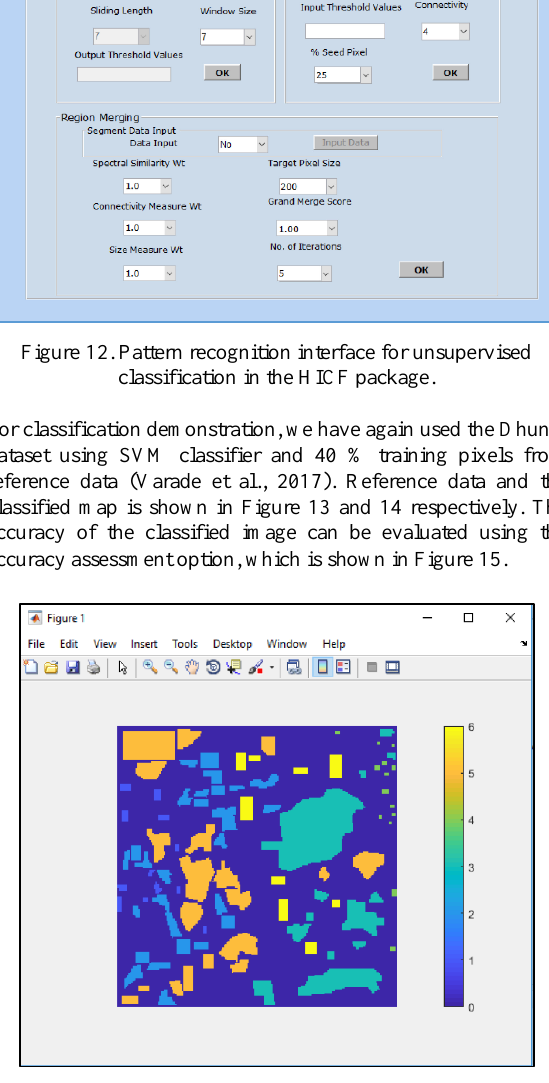
Figure 13. Example of reference data loaded in the classification